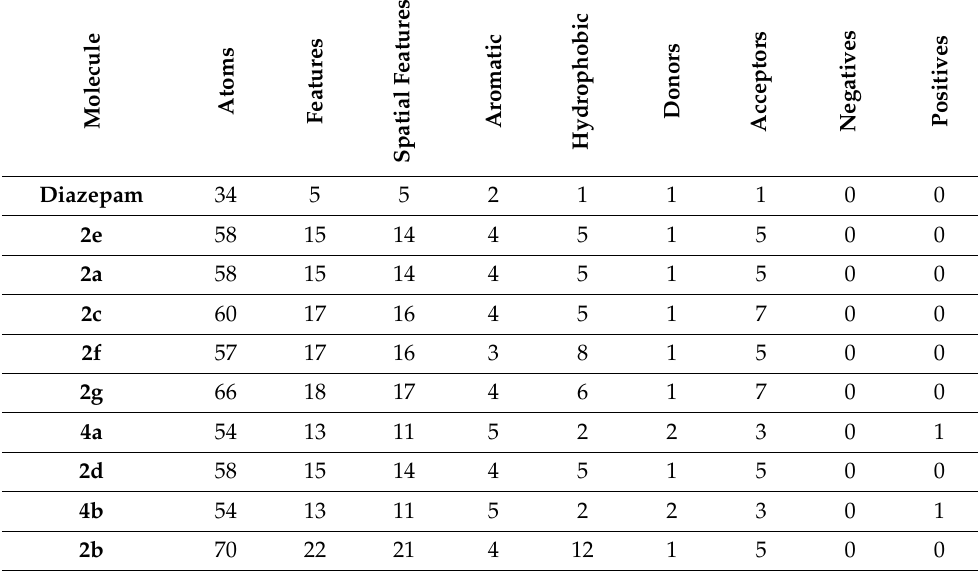
Table 6. Molecular features of input